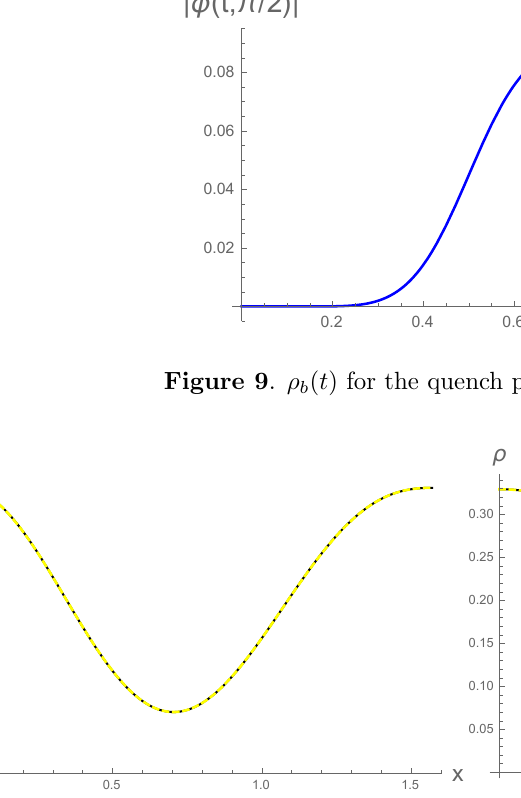
Figure 10 . In dotted black f ( x ) and (cid:26) ( x ) at the end of the driving phase for a quench process of the form (3.1) with time span (cid:12) = 2500 and (cid:12)nal harmonic driving data ( ! b = 2 ; (cid:15) = 0 : 09). In solid yellow, f ( x ) and (cid:26) ( x ) of the SPS corresponding to the same data. The curves lie with high accuracy on top of each